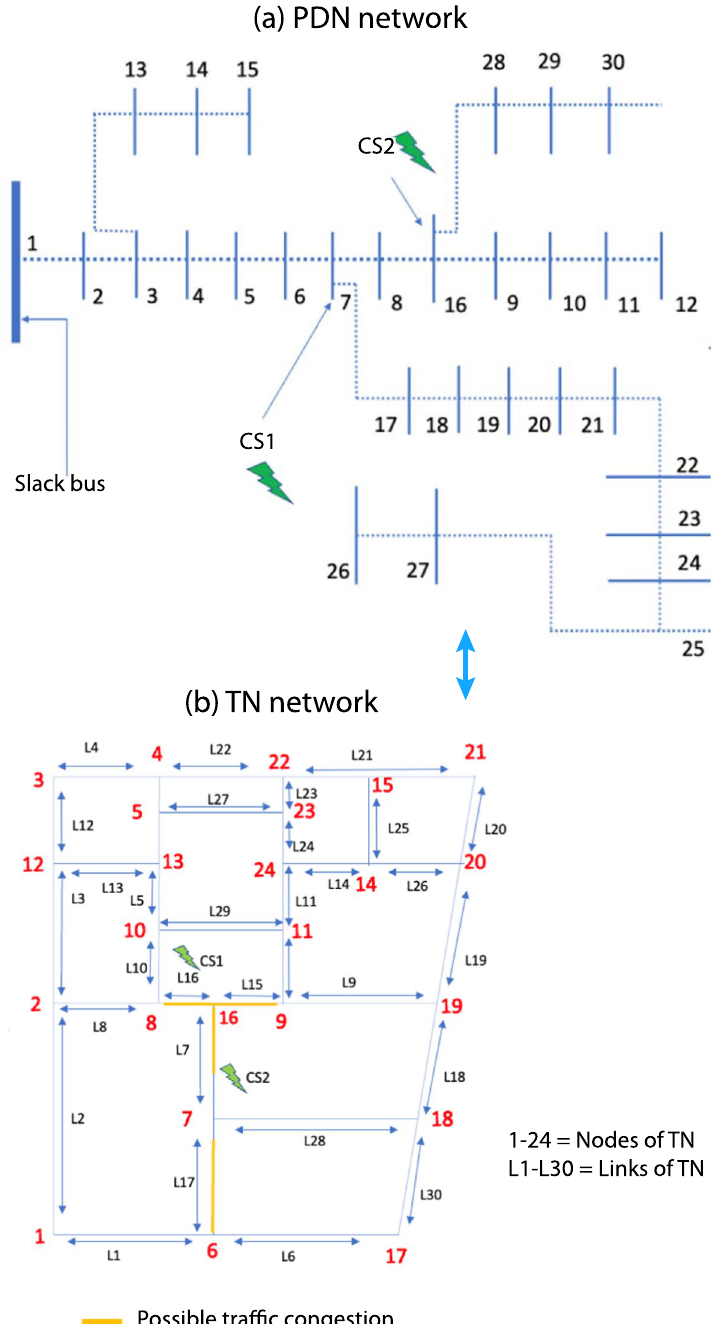
Fig. 2 a IEEE 30-node radial power network as a base layout for the PDN. b coupled with charging stations CS1 and CS2 in the transportation network with the travel links and nodes. The yellow lines in TN denote possible traffic congestion. The links of the TN are shown by L1–L30 and the nodes are denoted in red from 1 to